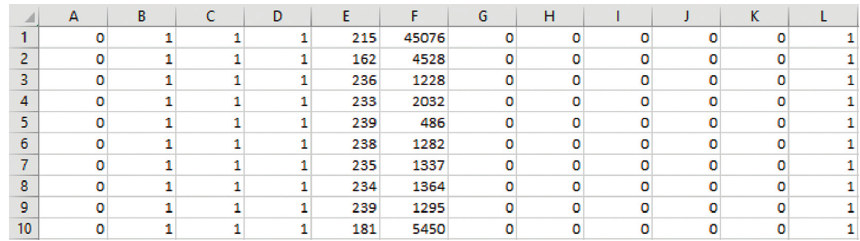
Figure 2: Sample of the dataset.